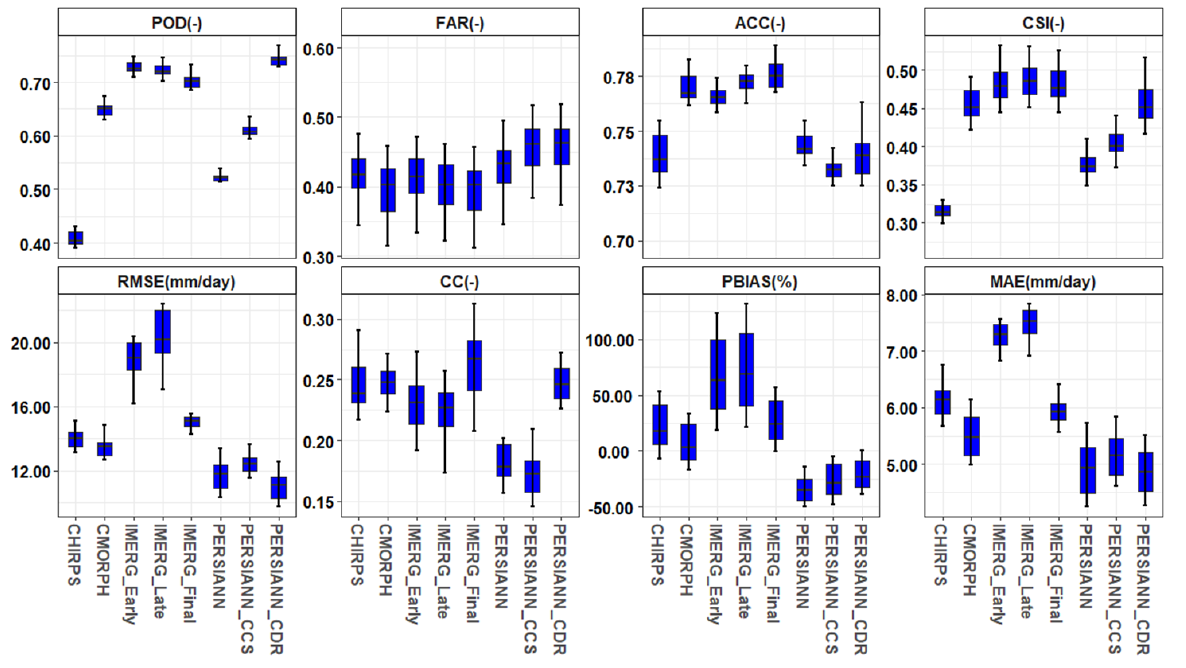
Figure 4. Box plot of categorical (POD, FAR, ACC, CSI) and continuous (RMSE, CC, PBIAS MAE) variable performance indicators at each station across the Simat Khola River Basin from 2003 to 2018.